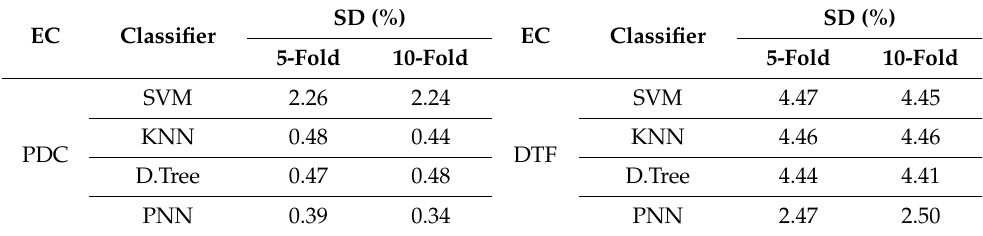
Table 4. Standard deviation (SD) of the accuracy for the classification of MI EEG based on the PDC and DTF when using 5- and 10-fold